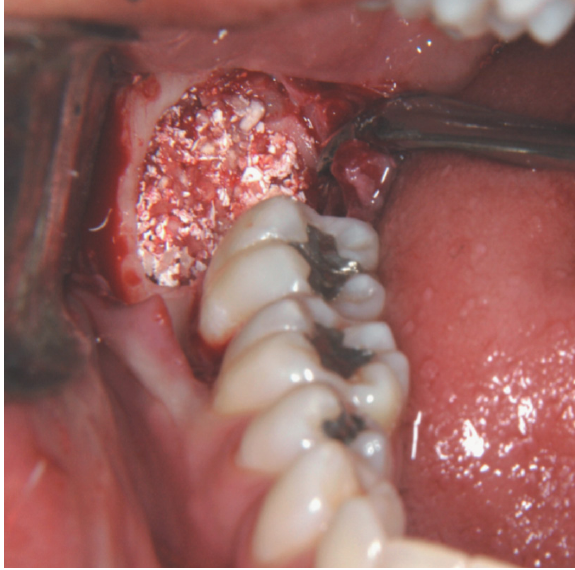
Figure 2- Measurement from the crest of alveolar bone to the cementoenamel junction (CEJ) filled by biomaterial (a) and